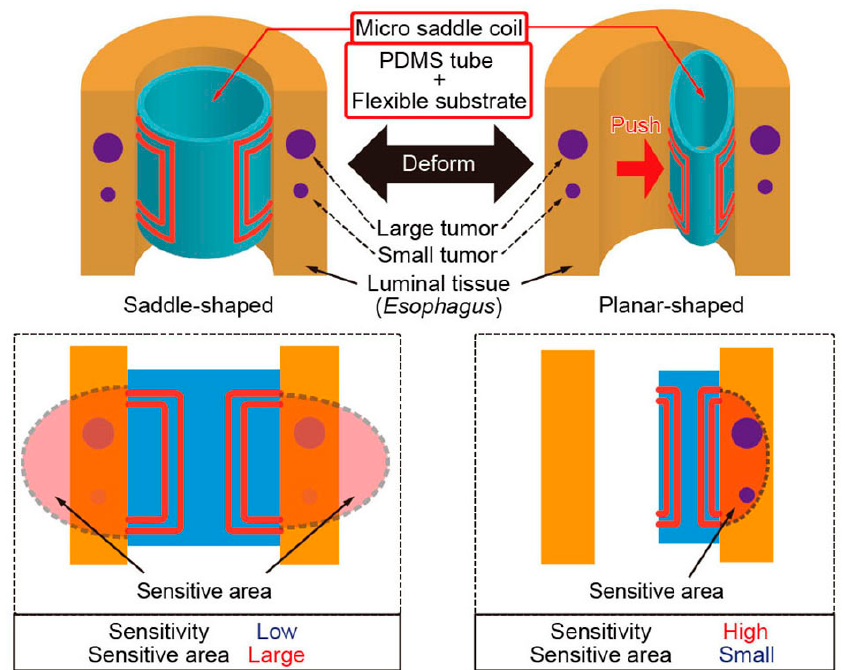
Figure 2. Concept of the micro saddle coil with switchable sensitivity. The micro coil of the saddle-shaped mode does not have high sensitivity, but has a large sensitive area. On the other hand, since the shape of the micro coil of planar-shape mode is like a double-layered flat micro coil, it has a small but highly sensitive area.